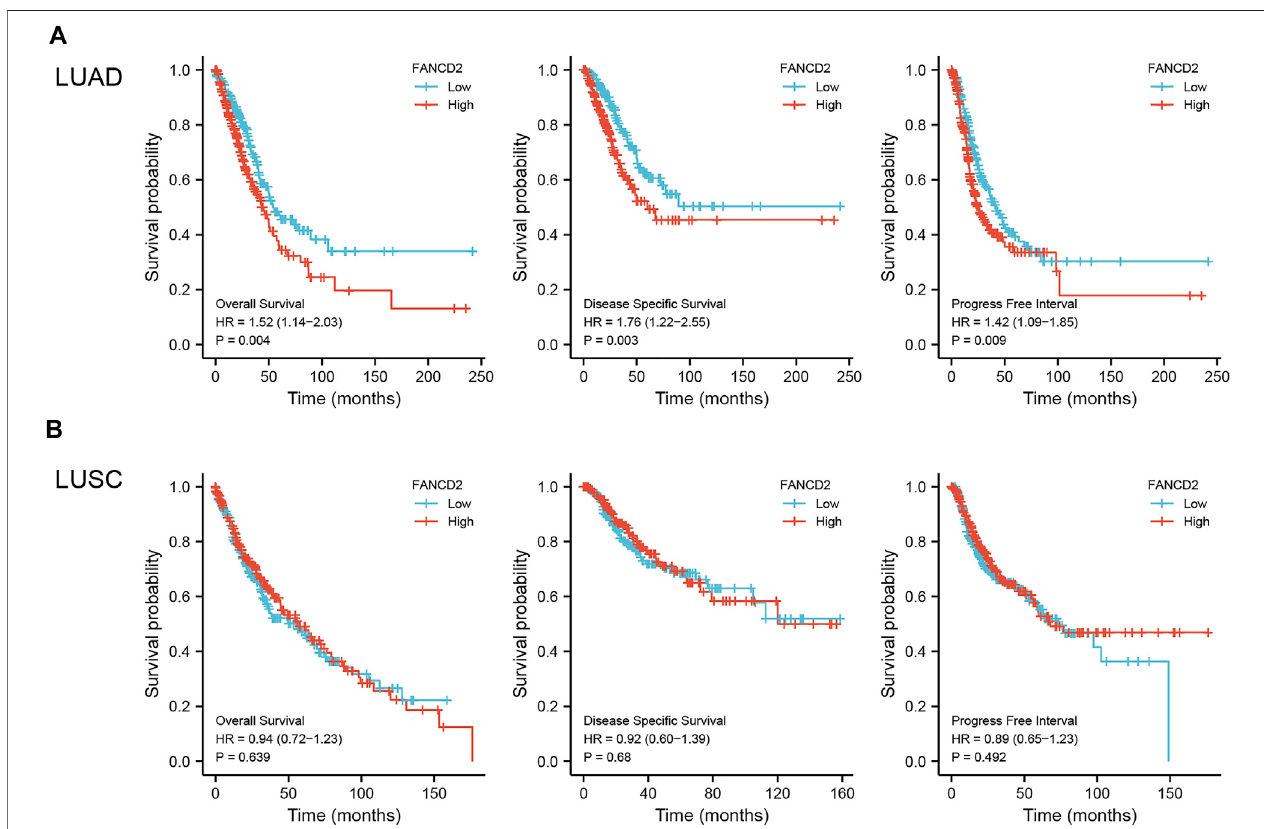
FIGURE 4 | Kaplan – Meier (K-M) survival curves showing the association between FANCD2 expression levels and overall survival (OS), disease-speci fi c survival (DSS), and the progression-free interval (PFI) for LUAD (A) and LUSC (B) patients; p < 0.05 was used to assess differences.